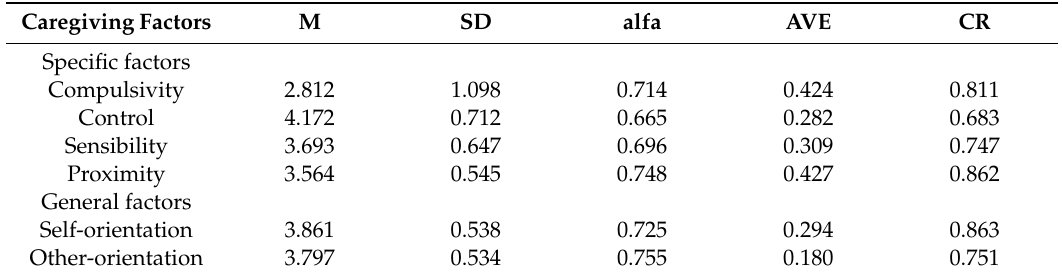
Table 2. Descriptive statistics and reliability of caregiving factors.